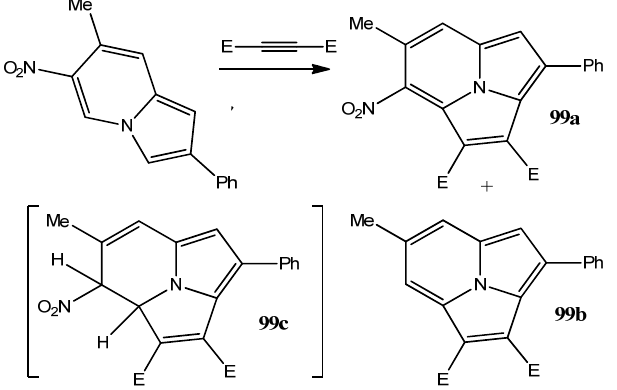
Scheme 54. Unusual cycloaddion to 6-nitroindolizine with the loss of NO 2